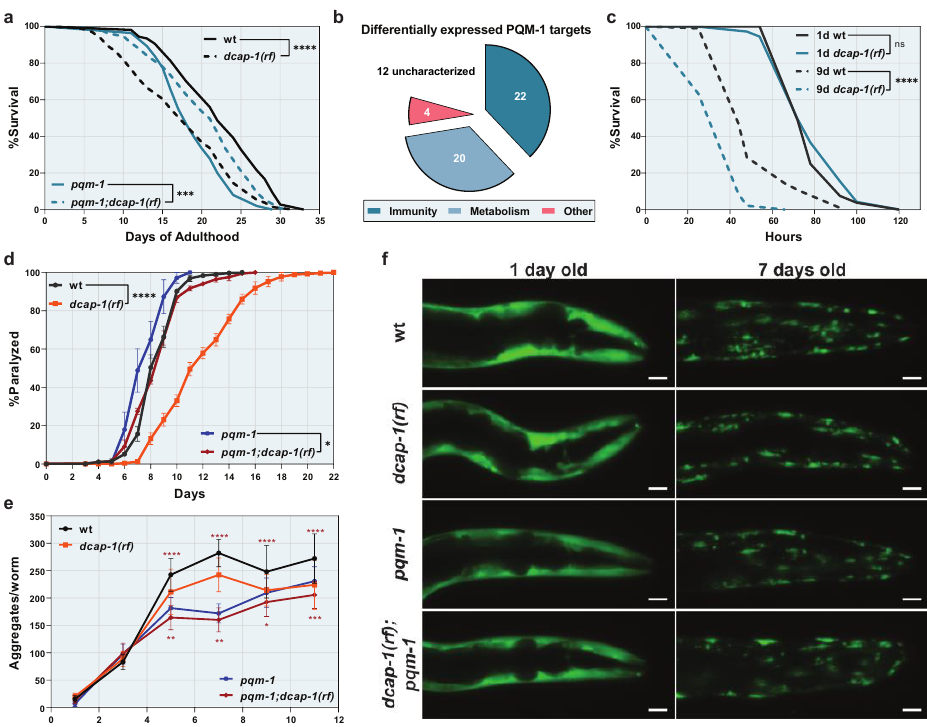
Figure 4. PQM-1 induction is detrimental for the lifespan of dcap-1(rf) animals but provides resistance to proteotoxicity. ( a ) Lifespan of dcap-1(rf) worms (dashed lines) in the presence or the absence of PQM-1, compared to their respective wt controls (solid lines). ( b ) Functional categorization of predicted PQM-1 targets, differentially expressed in dcap-1(rf) animals. See also Table S8. ( c ) Survival of 1 day (solid lines) and 9 day-old (dashed lines) wt and dcap-1(rf) worms after exposure to P. aeruginosa PA14. (d-e) Paralysis rate ( d ) (mean ± SEM) and number of aggregates per worm ( e ) (mean ± SD) of dcap-1(rf) animals that express Q35::YFP in their muscles, in the presence (orange) or the absence (red) of PQM-1, compared to their respective controls (black stars indicate comparisons between dcap-1(rf) and wt, while red stars indicate comparisons between pqm-1 and pqm-1;dcap-1(rf) ). ( f ) Representative fluorescent images (maximum projections) showing the aggregation of Q35::YFP peptides during ageing in dcap-1(rf) animals, in the presence or absence of PQM-1, compared to their respective controls. Scale bar = 2 0μm. See also Figure S4. * p < 0.05, ** p < 0.01, *** p < 0.001, **** p < 0.0001. Log-rank (Mantel-Cox) test ( a , c ), Two-way ANOVA ( d ), One-way ANOVA